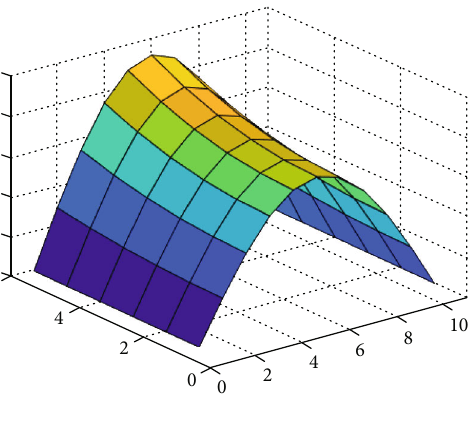
Figure 1: p = 1 , k = 0 : 5 :